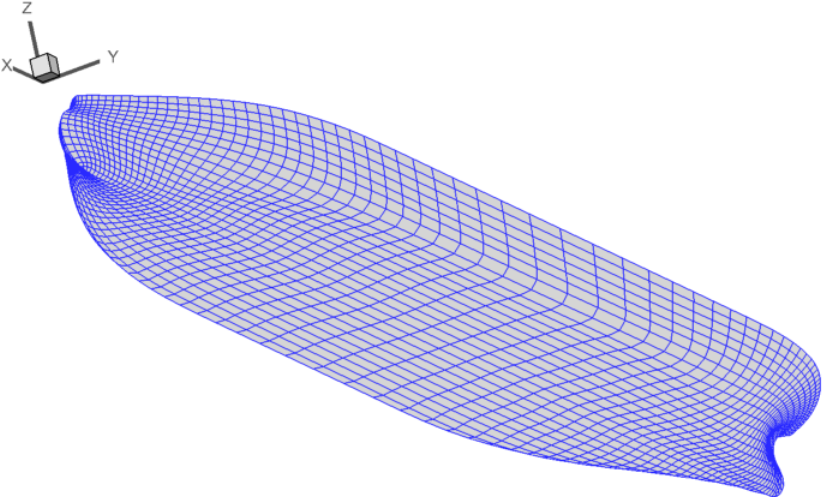
Figure 13. Panels modeled on the model hull [32].